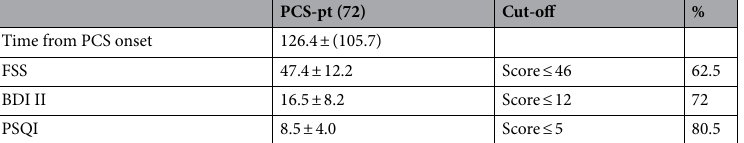
Table 3. PCS patients’ clinical assessment: for each questionnaire, scale or index, in column the cut-off scores (which are indicated from the international literature) have been reported. The last column reports the percentage of patients having pathological scores. PCS post COVID-19 syndrome, FSS fatigue severity Scale, BDI II beck depression inventory II, PSQI Pittsburgh sleep quality index.